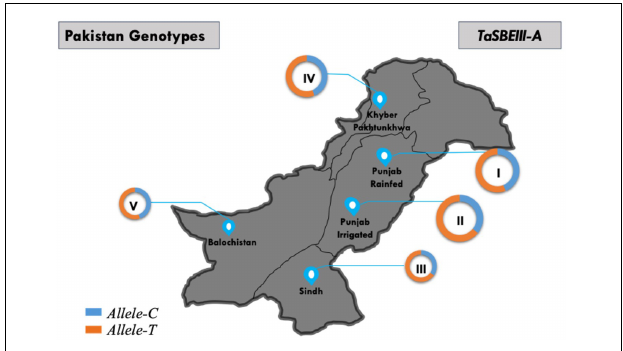
FIGURE 6 | Distribution of TaSBEIII-A alleles among Pakistan accessions. I, Punjab rainfed zone; II, Punjab irrigated zone; III, Sindh region; IV, Balochistan zone; V, Khyber Pakhtunkhwa zone. Pie chart size is directly proportional to the number of